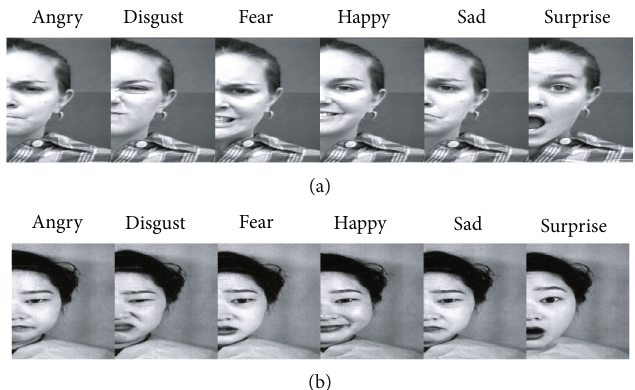
Figure 3: Sample of right half-face images under varying expressions (test-image database 2): (a) right half-face image under varying expressions from CKFE database. (b) right half-face image under varying expressions from the JAFFE